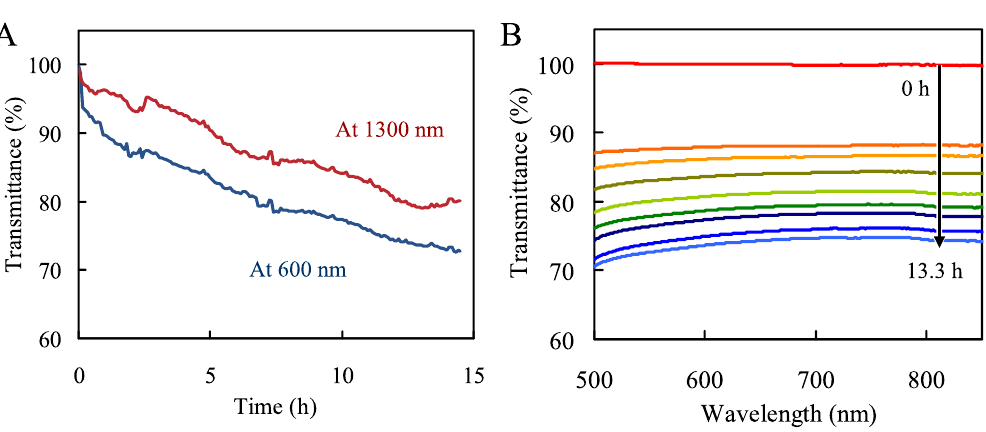
Figure 2. ( A ) Transmittance response monitored by the fiber sensor with 24 cm exposed core length at 600 nm (blue line) and 1300 nm (red line) as a function of time after immersion in geothermal water at Sumikawa Geothermal Power Plant. ( B ) Spectral changes with time from 500 to 850 nm with the fiber sensor under the same conditions. Curves from top to bottom represent increase in